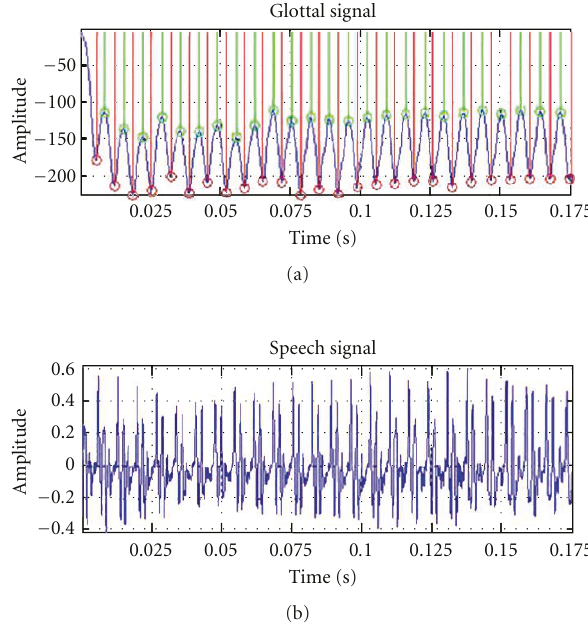
Figure 4: Extracted glottal signal and its corresponding speech